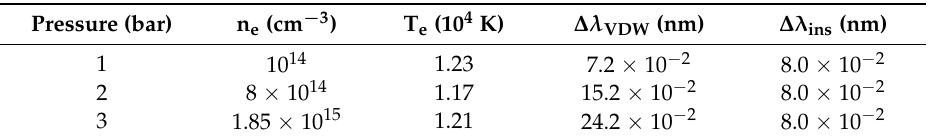
Table 5. Results of the fitting GA analysis of the H- β line. n e : electron density; T e : electron temperature; ∆ λ ∆ λ VDW : van der Waals width; ins : Gaussian width.